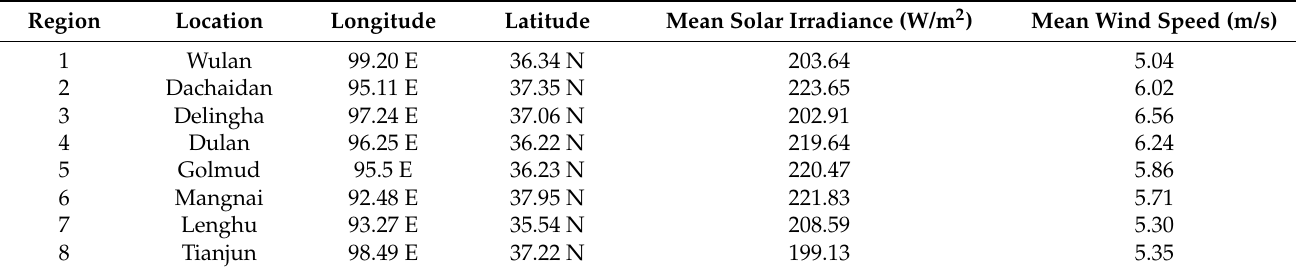
Table 2. The basic information about the selected regions.